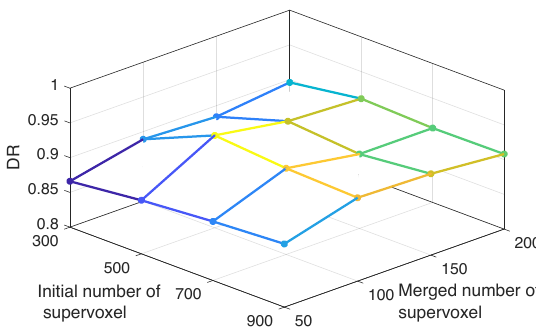
Figure 4. Mean Dice ratio on the training set using four different M and N values.